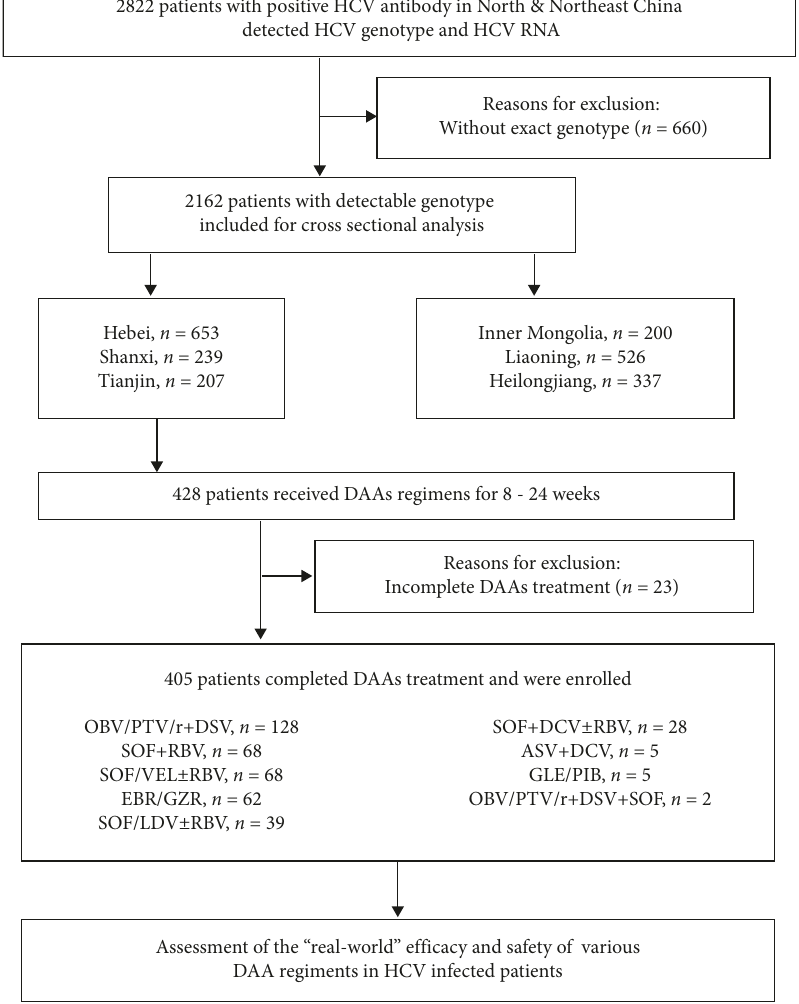
Figure 1: Flowchart of chronic hepatitis C virus (HCV) infected patient enrollment and follow-up. DAAs: direct-acting antivirals; OBV/ PTV/r: ombitasvir/paritaprevir/ritonavir; DSV: dasabuvir; SOF: sofosbuvir; RBV: ribavirin; EBR/GZR: elbasvir/grazoprevir; VEL: vel- patasvir; DCV: daclatasvir; ASV: asunaprevir; LDV: ledipasvir; and GLE/PIB: